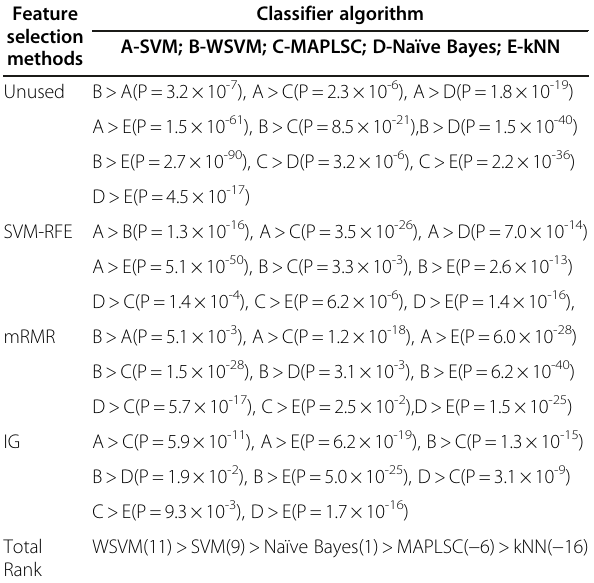
Table 5 P value of statistical comparisons among the five classifiers on the lip images data Feature